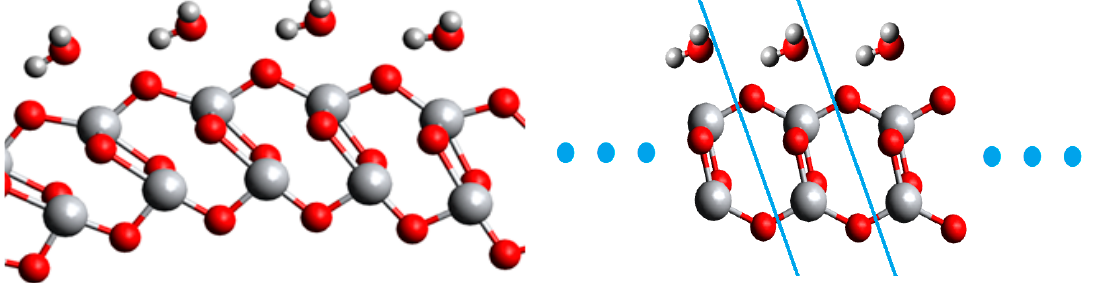
Figure 10. Fragment of a 6-layered (001) TiO 2 NT (40,0) and its 2D FVS model, with a multiplied unit cell.